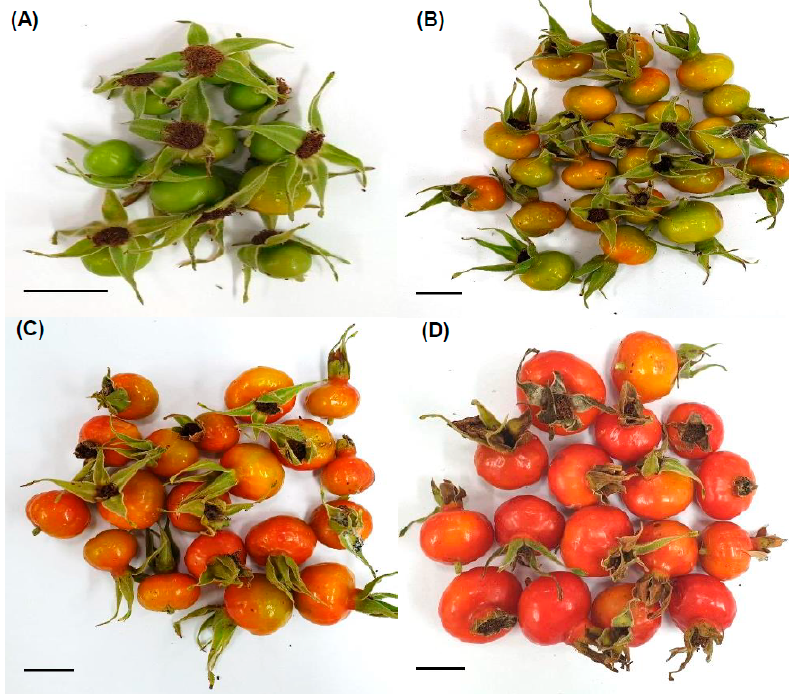
Figure 1. Representative images of rose hips at various ripeness stages. ( A – D ) indicate representative images of harvested rose hips from immature and early-, mid-, and late-ripeness stages, respectively. Each scale bar in the lower left of the picture indicates 1 cm.